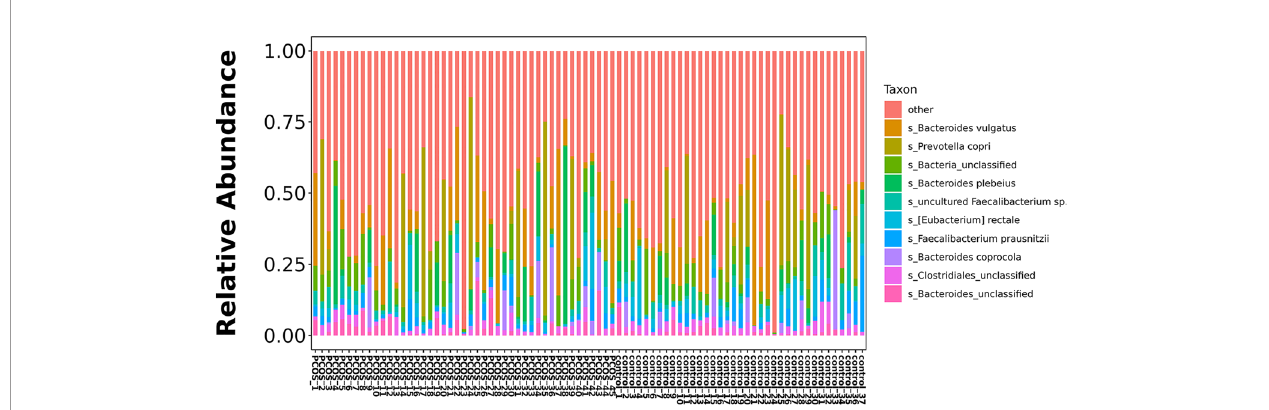
FIGURE 2 | Histogram of top 10 species composition in